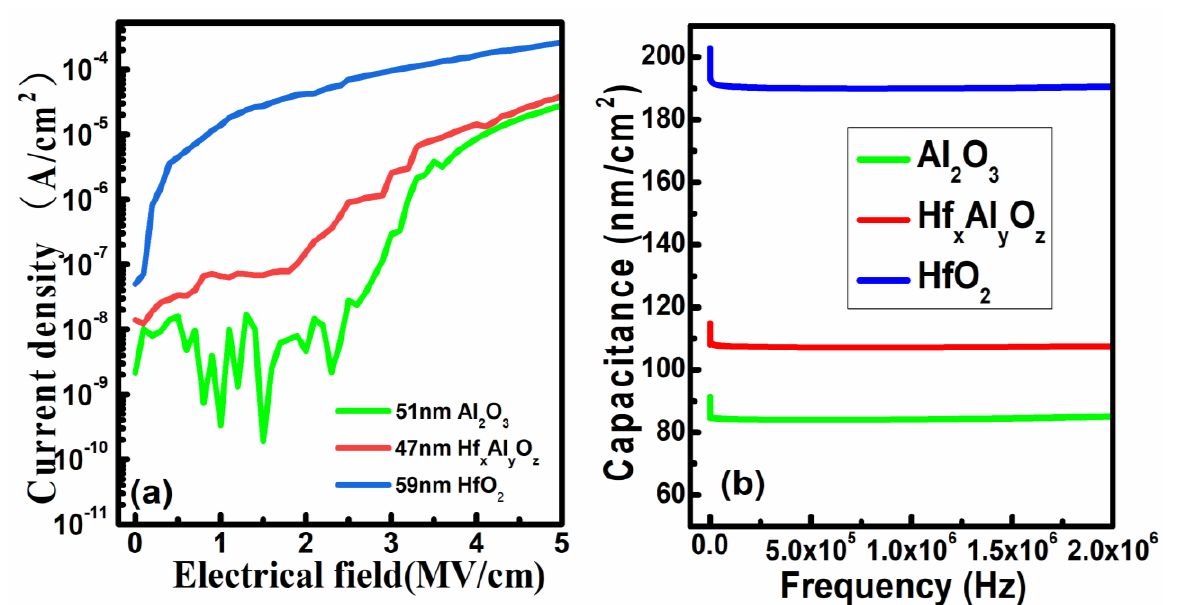
Figure 4. ( a ) Leakage current density of different dielectrics; ( b ) capacitance-frequency measurements as a function of frequencies from 20 Hz to 2 MHz.